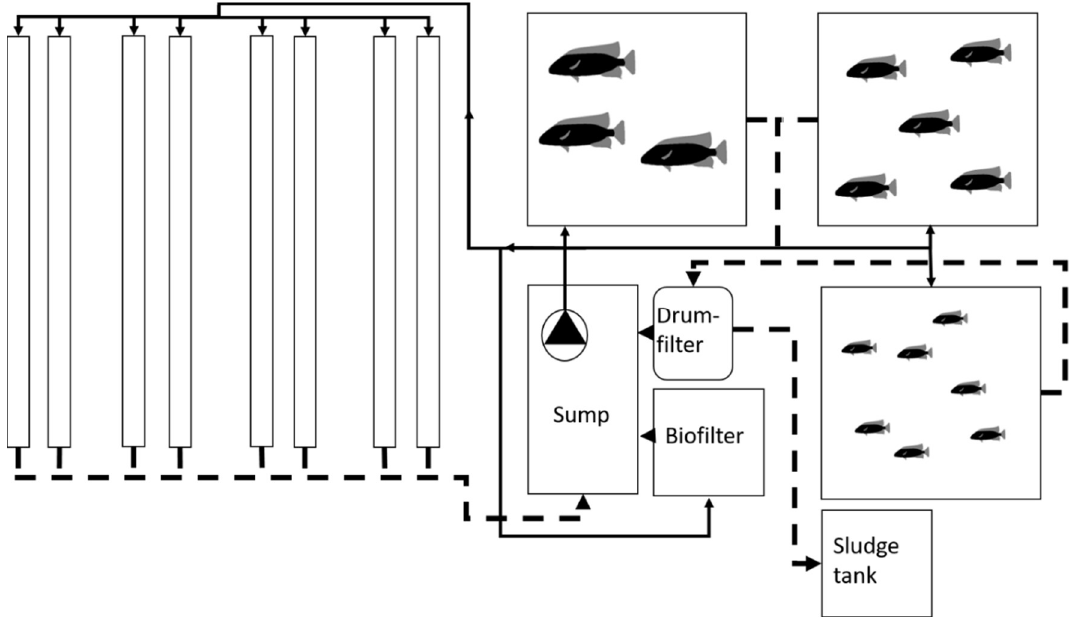
Figure 8. The design of a small-scale commercial production system in the greenhouse farm. The design is based on using only one pump to run the whole system. The arrows indicate water flow through the system, the solid lines indicate pipes from the pump while the dashed lines indicate return pipes. The water runs from the sump to both the plants and the fish tanks.